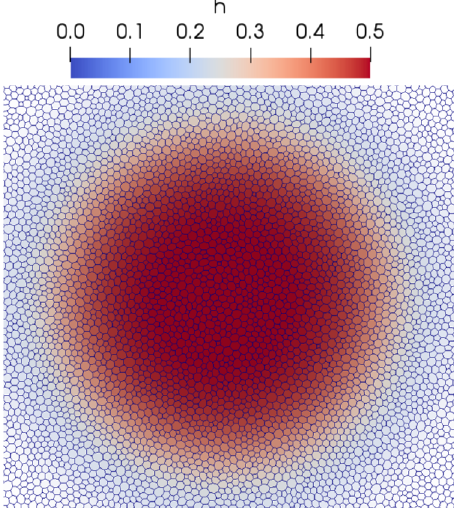
molecules.FIG. 17. A polyhedral dual mesh (blue cells) and correspond- ing height field h used by the forcedThinFilmFoam program